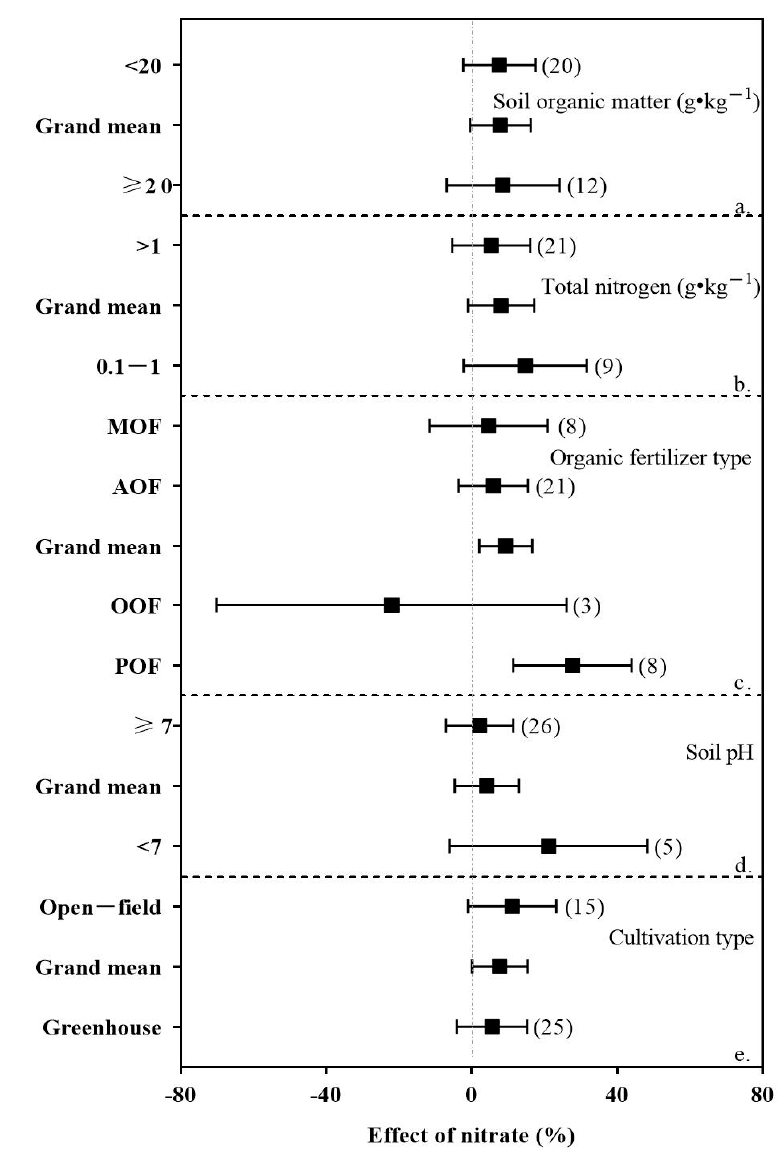
Figure 10. Organic fertilizers combined with soil organic matter ( a ), total soil nitrogen ( b ), type of organic fertilizers ( c ), soil pH ( d ), and cultivation type ( e ) on tomato nitrate percentage changes. Points represent the mean effect, while bars represent 95% confidence intervals. The numbers on the right side of the confidence intervals represent the sample sizes. AOF, animal organic fertilizer; MOF, mixed animal-and-plant organic fertilizer; POF, plant organic fertilizer; OOF, other organic fertilizer.